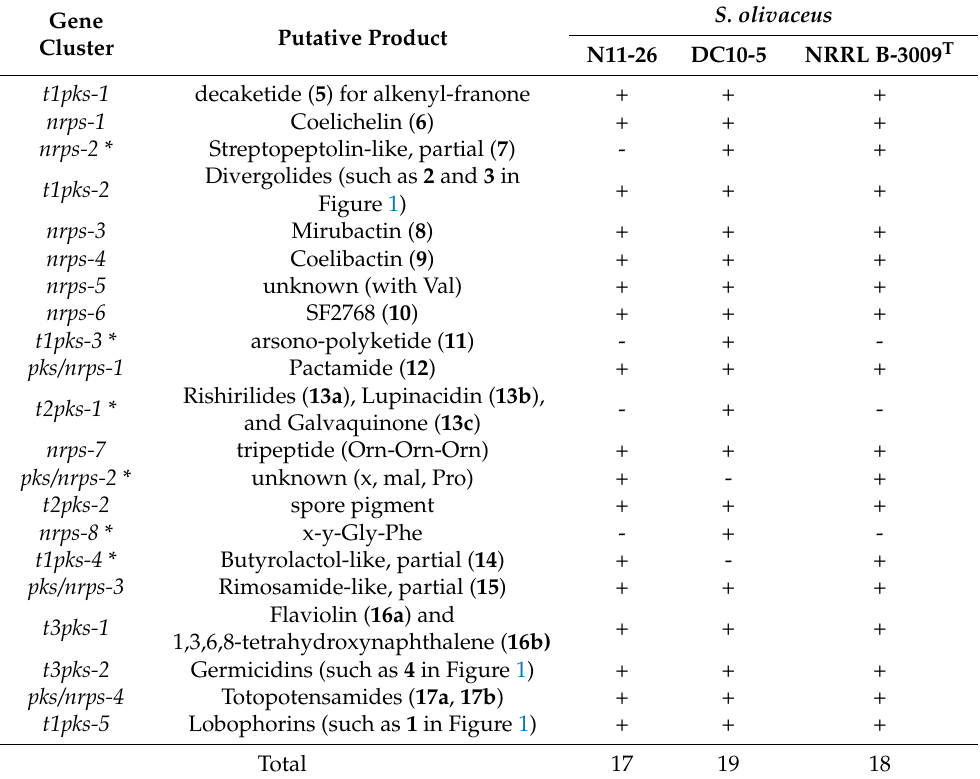
Table 3. PKS and NRPS gene clusters in the genomes of S. olivaceus N11-26, DC10-5 and NRRL B-3009 T . Gene